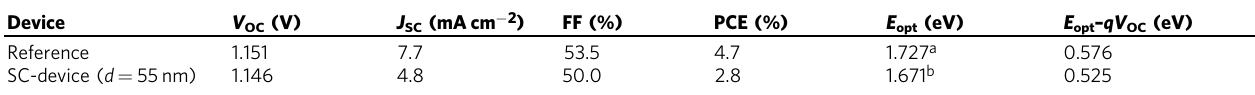
Comparison between a reference device under no strong coupling, and an exemplary SC-device with d = 55nm. Strong coupling does not affect the V OC of the device, while the red-shifting of the E opt leads to a reduction of the E opt – qV OC losses a Obtained as the crossing point of the device ’ s EQE and EL spectra b Obtained as the peak of the lower polariton